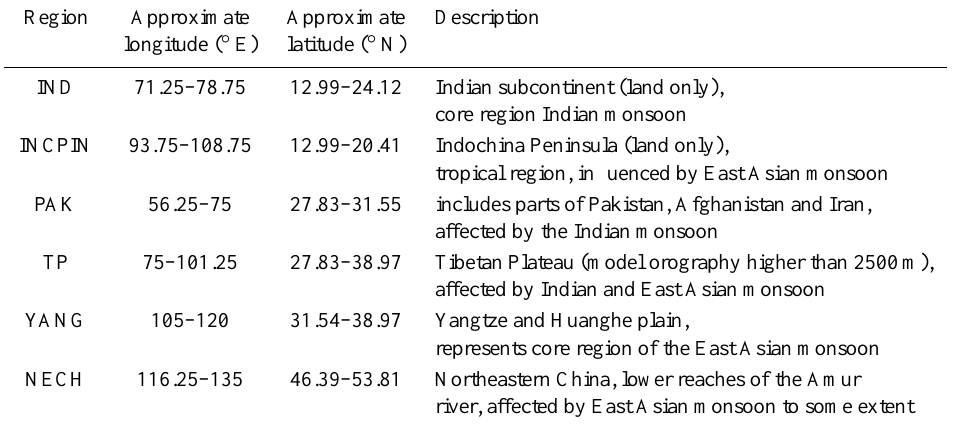
Table 2. Description of the areas we consider in our feedback study. Listed are the abbreviation, geographic position (latitude and longitude of grid-box centers) as well as a short characterisation. For location and shape of the regions see also Fig. 1.